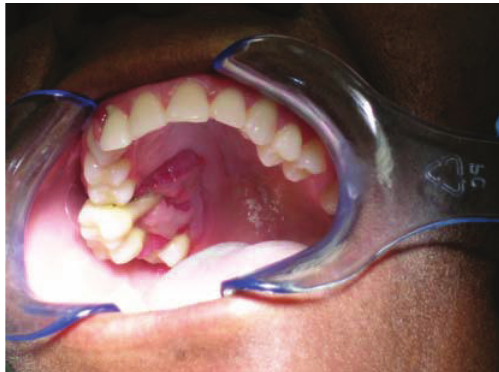
Figure 5: Case 4. Ulcerated, exophytic palatal mass with destruction of the bone and exposed dental roots.